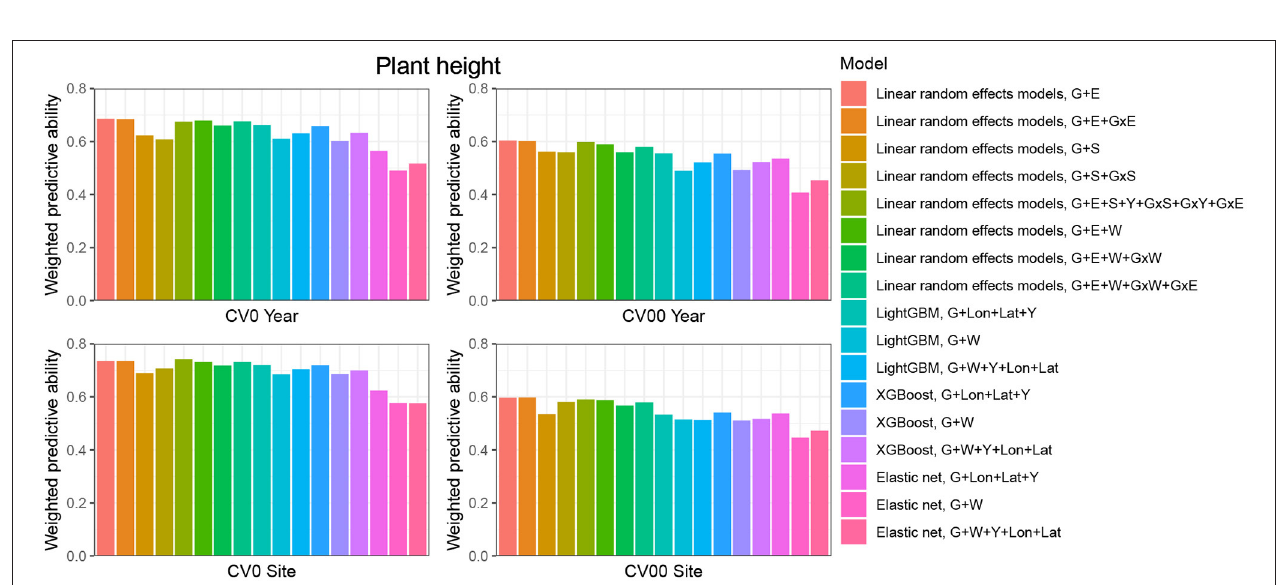
FIGURE 3 | Weighted average predictive ability across 71 environments obtained for four cross-validation schemes and 16 models for the trait grain yield. G, main effect of SNPs markers (genomic relationship matrix for LRE models; principal components derived from marker matrix for machine learning-based approaches); Y, year effect; S, site effect; GxS, genotype-by-site interaction; E, environment effect; GxY, genotype-by-year interaction; GxS, genotype-by-site interaction; GxE, genotype-by-environment interaction; GxW, interaction between W and SNPs; Lon, longitude; Lat, latitude; W, effect of weather- and soil-based covariates. For linear random effects models, results with models including longitude and latitude data in the matrix W are depicted here.